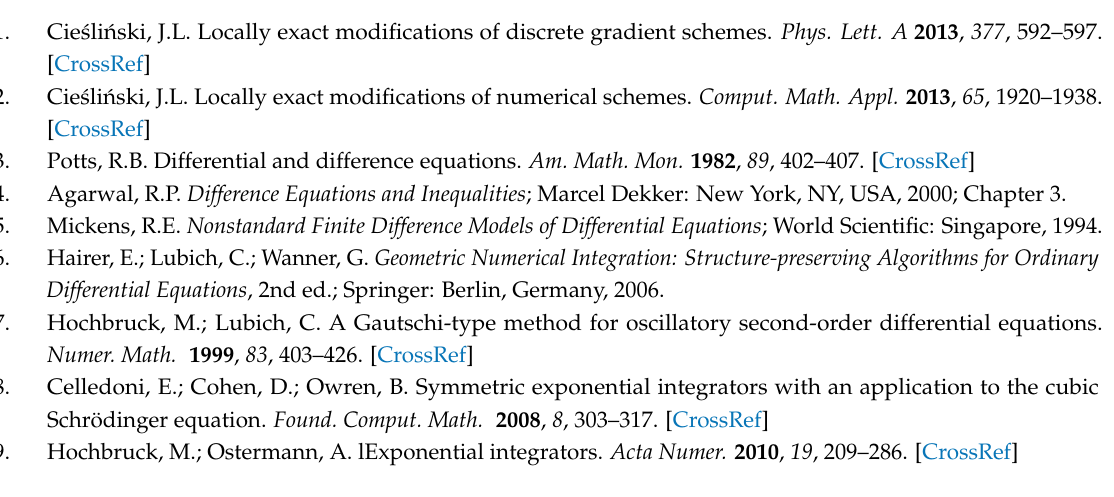
Figure 6. Errors of GR-LEX (black) compared to errors of IMR-LEX (red) near equilibrium: x 0 = 1/ p 0 =